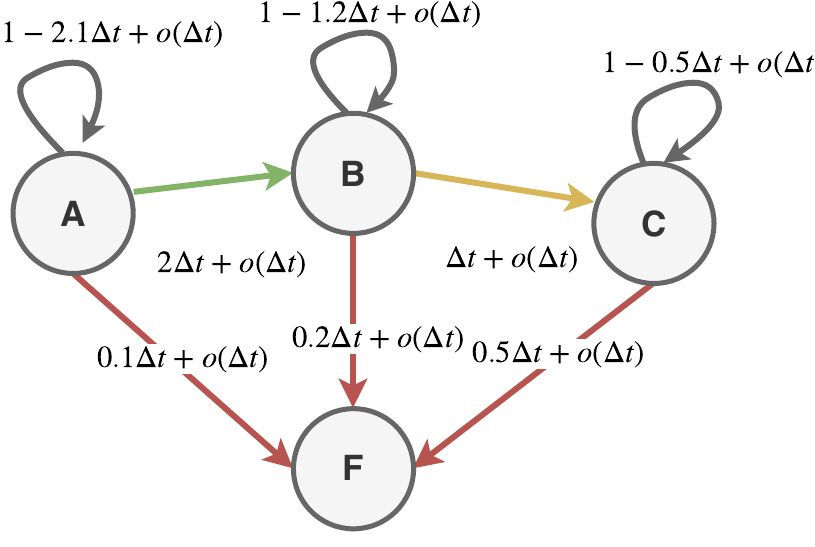
Figure 2. Graphical representation of the Markov chain of the solution of the Kolmogorov differential equations of the proposed